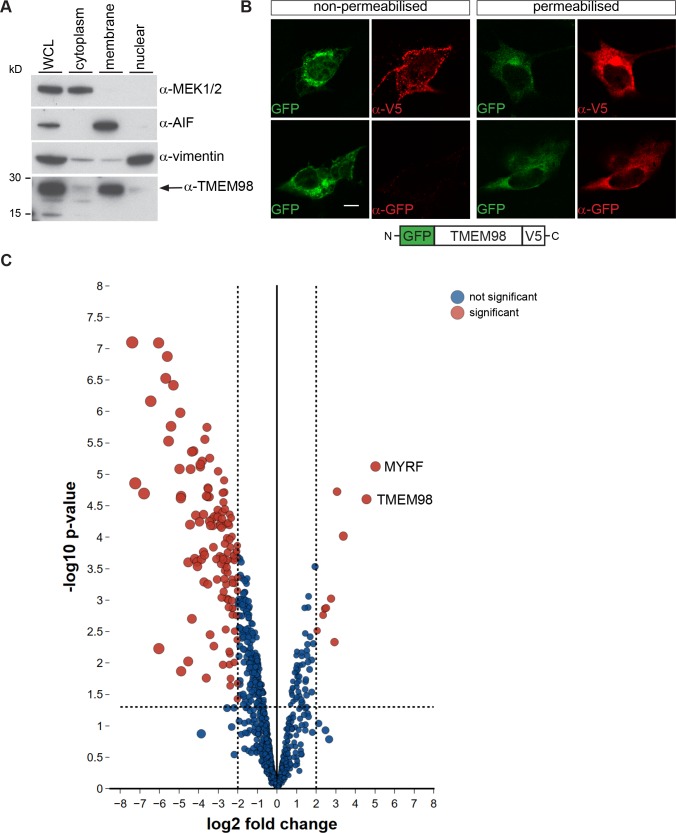
TMEM98 is a type II transmembrane protein and interacts with MYRF.(A) Western blot analysis of ARPE-19 subcellular fractions probed with the indicated antibodies. The control antibodies against MEK1/2, AIF and VIMENTIN are found in the expected fractions. TMEM98 is present in the membrane fraction. Uncropped Western blot images are shown in S8 Fig. WCL = whole cell lysate (B) Topology of TMEM98. NIH/3T3 cells were transiently transfected with GFP-TMEM98-V5 (green) and immunostained with anti-GFP or anti-V5 antibodies (red). Non-permeabilised cells are shown on the left and permeabilised cells are shown on the right. On the top row transfected cells stained with an anti-V5 antibody are shown and on the bottom row transfected cells stained with an anti-GFP antibody are shown. Accessibility to the antibodies indicates that the GFP epitope is intracellular and that the V5 epitope is extracellular. A schematic of the expression GFP-TMEM98-V5 construct is shown below. (C) Volcano plot of the mass spectrometry data comparing proteins biotinylated by TMEM98-BirA* with those by BirA* alone. The x axis is log2 fold change of TMEM98-BirA* peptides versus BirA* peptides and the y axis is–log10 p-value of significance. The horizontal dashed line shows where p = 0.05 (−log10(0.05) = 1.3) and the vertical dashed lines show where fold change is four. Proteins with significant difference and change greater than four-fold are shown in red, other proteins are shown in blue. The two most highly enriched proteins, TMEM98 and MYRF, are labelled.